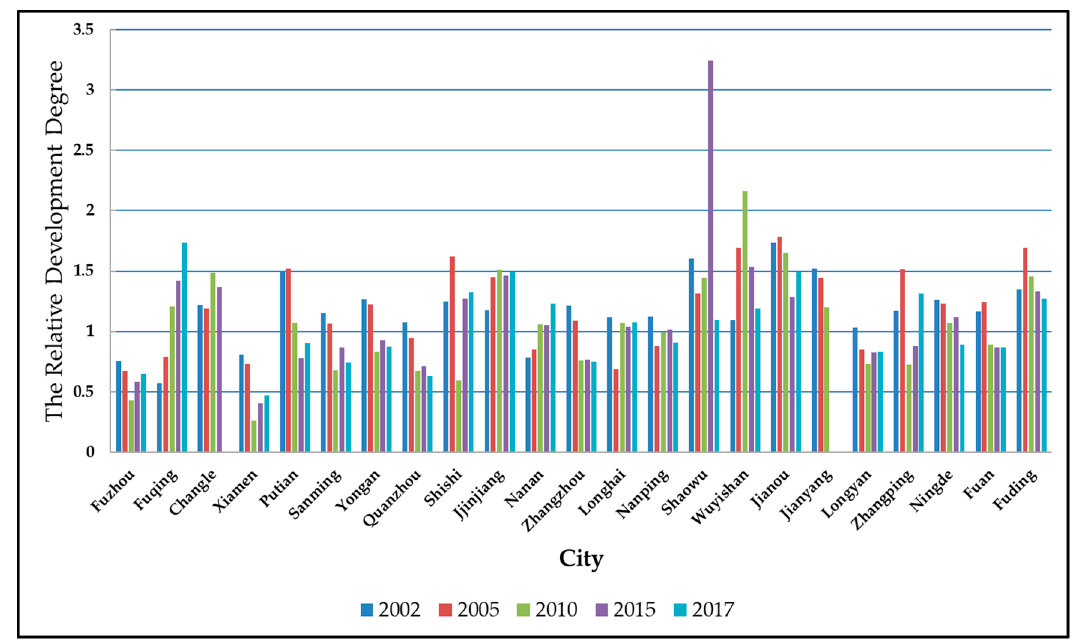
Figure 2. The relative development degree of urban land use efficiency and urbanization level.